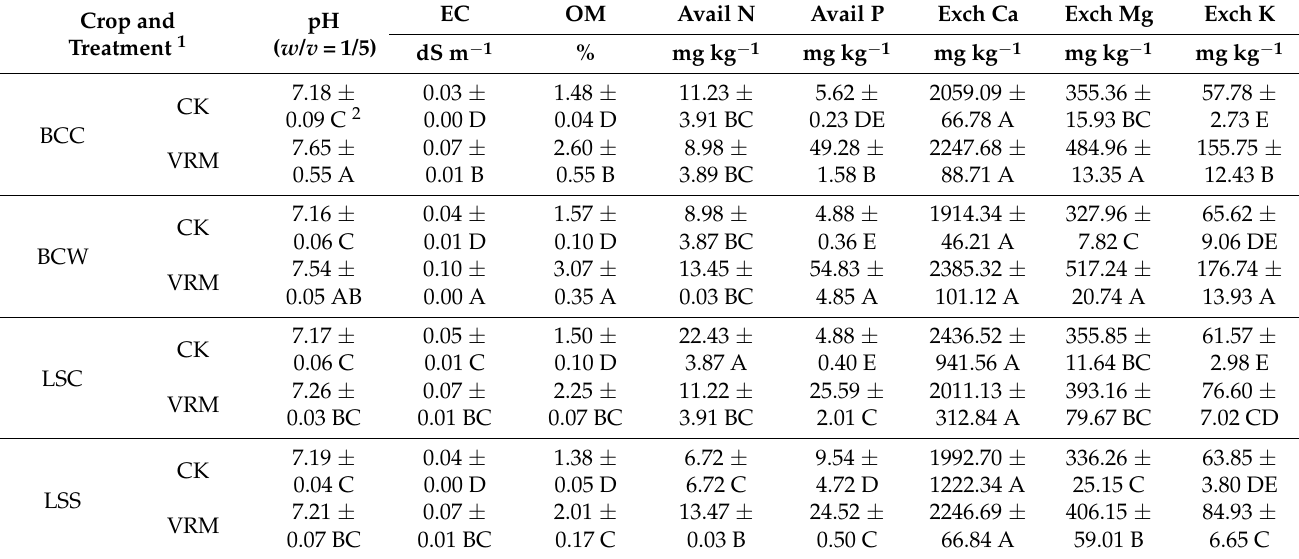
Table 2. The soil properties of the Y-400 soil under different